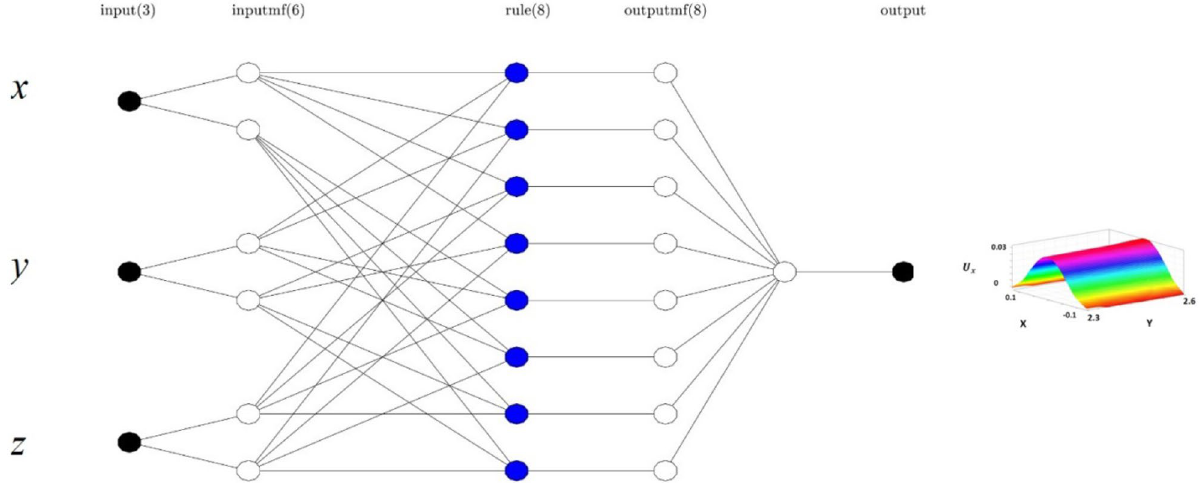
Figure 2. Adaptive neuro-fuzzy inference system pattern for the simulation of liquid velocity at different neural nodes. Input parameters are x, y, and z computing nodes in the bubble column reactor. Two membership functions are considered in each input parameter in the schematic